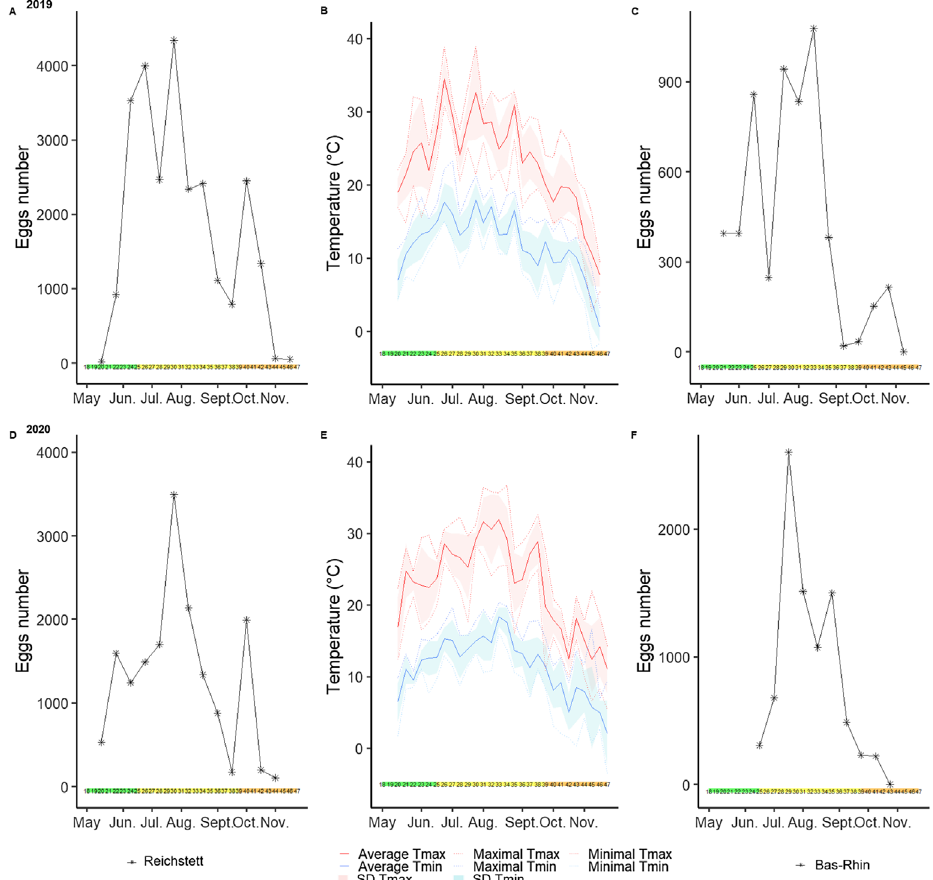
Figure 3. Aedes japonicus egg seasonality regarding environmental temperatures from May to November 2019 and 2020. Corresponding months and seasons are shown with coloured horizontal bars (green = spring, yellow = summer, orange = autumn). (A) 2019, egg seasonality in the Reichstett study site; (B) 2019, weekly temperatures are shown. The average maximal temperature per week is shown with a solid red line with the standard deviation shown in fi lled light red. Dotted red lines correspond to the maximal and minimal highest temperatures observed each week. Average minimal temperature is shown with a solid blue line with standard deviation in fi lled blue. Minimal and maximal colder temperatures are shown with dotted blue lines. (C) 2019, egg proportion from the Bas-Rhin Department is also shown with a solid black line with stars. (D) 2020, egg seasonality in the Reichstett study site; (E) 2020, weekly temperatures; (F) 2020 egg seasonality in the Bas-Rhin administrative